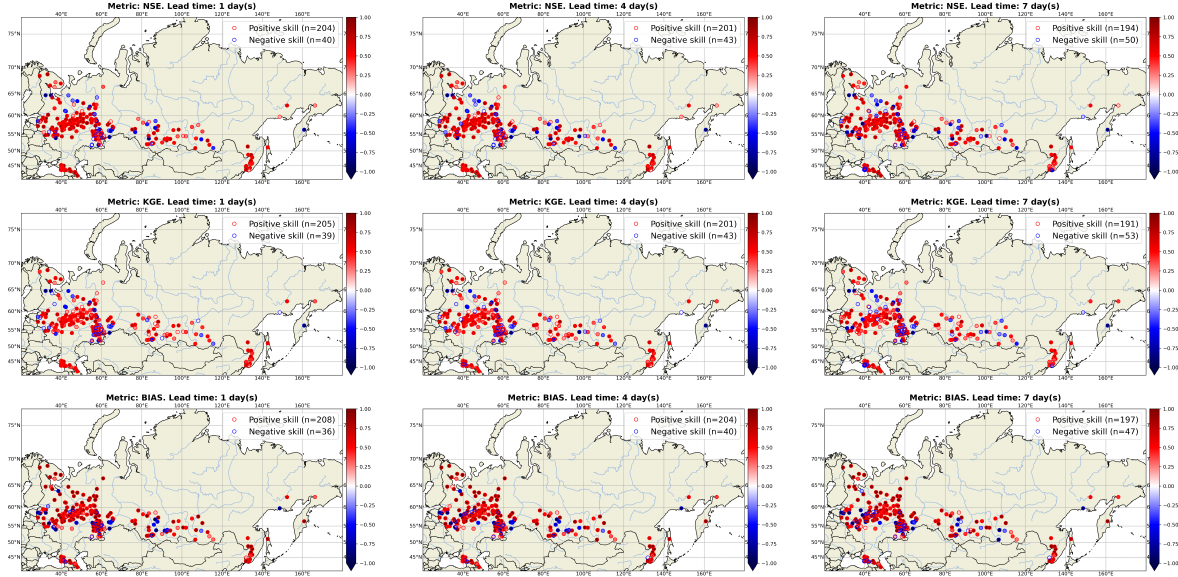
Figure 9. The skill of OpenForecastv2 with NSE (top row), KGE (middle row), and bias (bottom row) metrics for forecasts against the climatology benchmark for lead times of one (left column), three (middle column), and seven (right column)